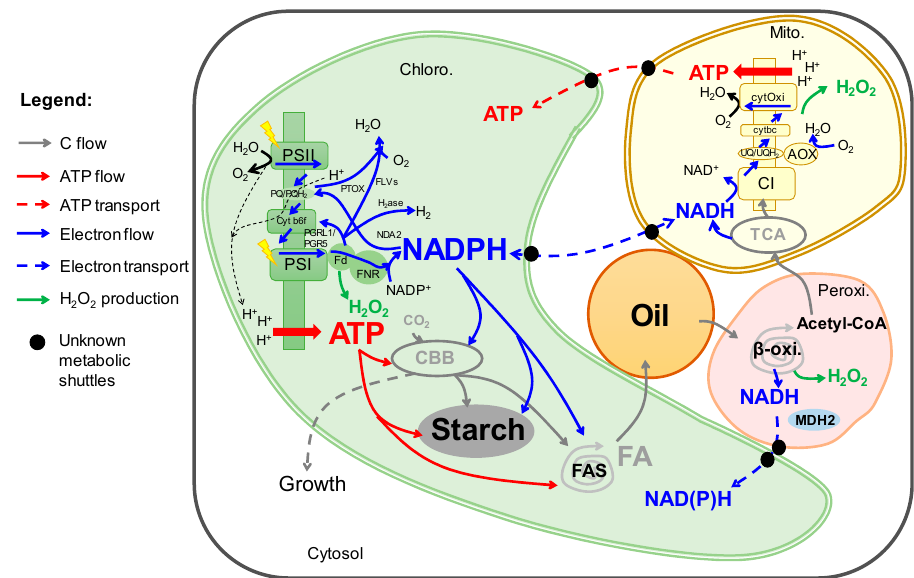
Figure 2. A pathway map showing energy production, management and carbon storage in a Chlamydomonas reinhardtii cell. Abbreviations: AOX, alternative oxidase; ATP, adenosine triphosphate; β -oxi., β -oxidation; CBB, Calvin Benson Bassham; C1, mitochondria respiratory complex 1; FA, fatty